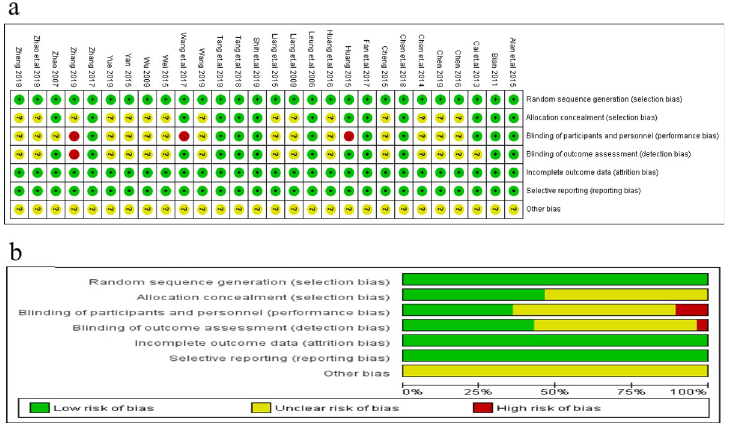
Fig 3. Risk of bias of the included trials: (a) Risk of bias in individual study; (b) Risk of bias